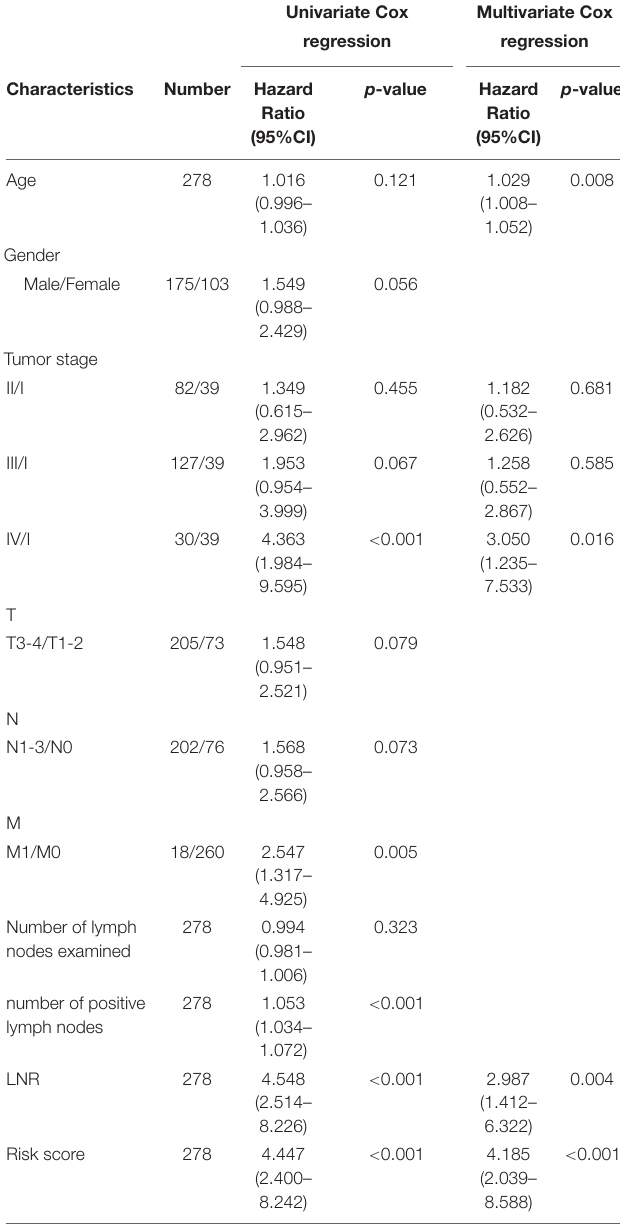
TABLE 1 | Univariate and multivariate Cox regression analyses of clinical characteristics and risk score in TCGA-STAD. Univariate Cox Multivariate Cox regression